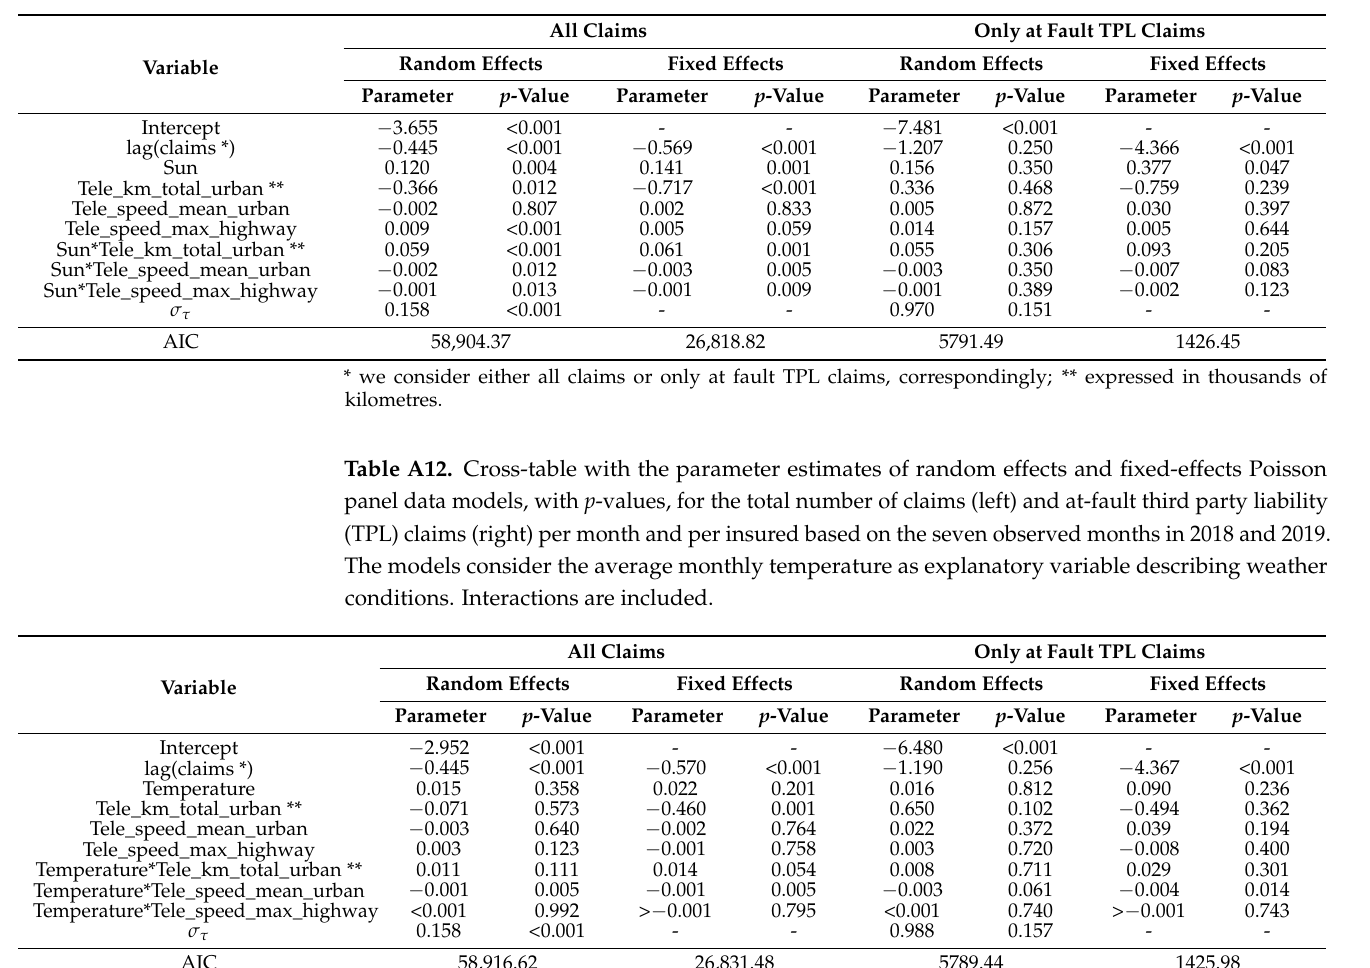
Table A11. Cross-table with the parameter estimates of random effects and fixed-effects Poisson panel data models, with p -values, for the total number of claims (left) and at-fault third party liability (TPL) claims (right) per month and per insured based on the seven observed months in 2018 and 2019. The models consider the average number of sunshine hours per day as explanatory variable describing weather conditions. Interactions are included.